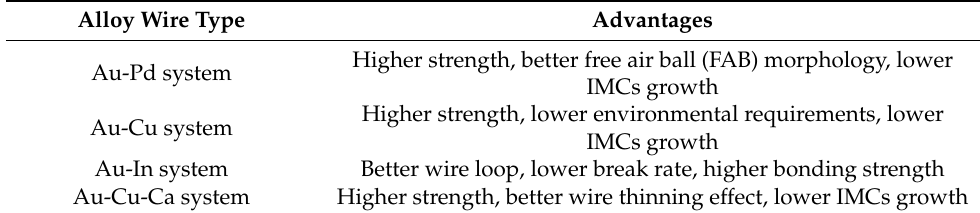
Table 1. Advantages of Au alloy wires versus traditional Au wire